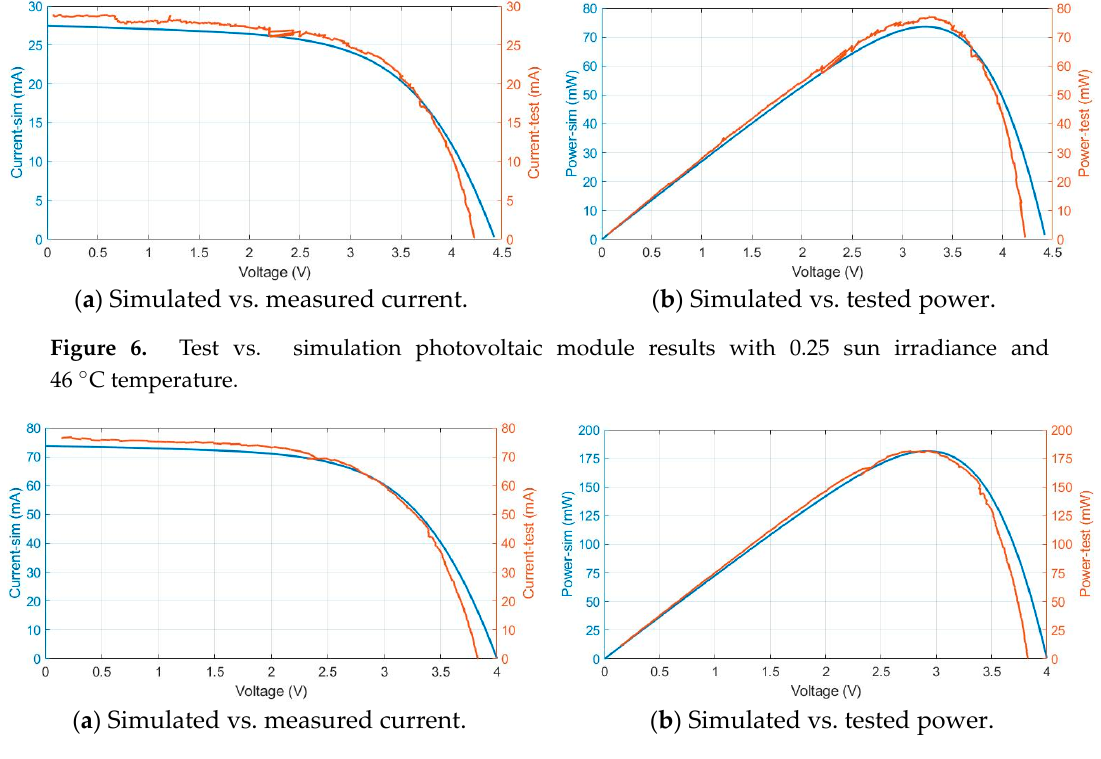
Figure 7. Test vs. simulation photovoltaic module results with 0.5 sun irradiance and 65 °C temperature.